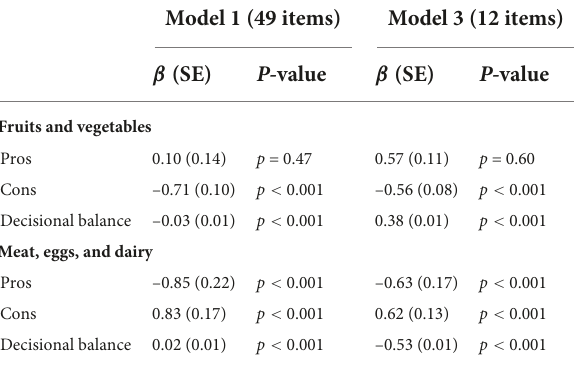
TABLE 4 Pros, cons, and decisional balance (IVs) and self-reported consumption outcomes (fruit and vegetables, and meat, eggs, and dairy) (DVs) using logistic regression adjusted for age, sex, income, race/ethnicity, and